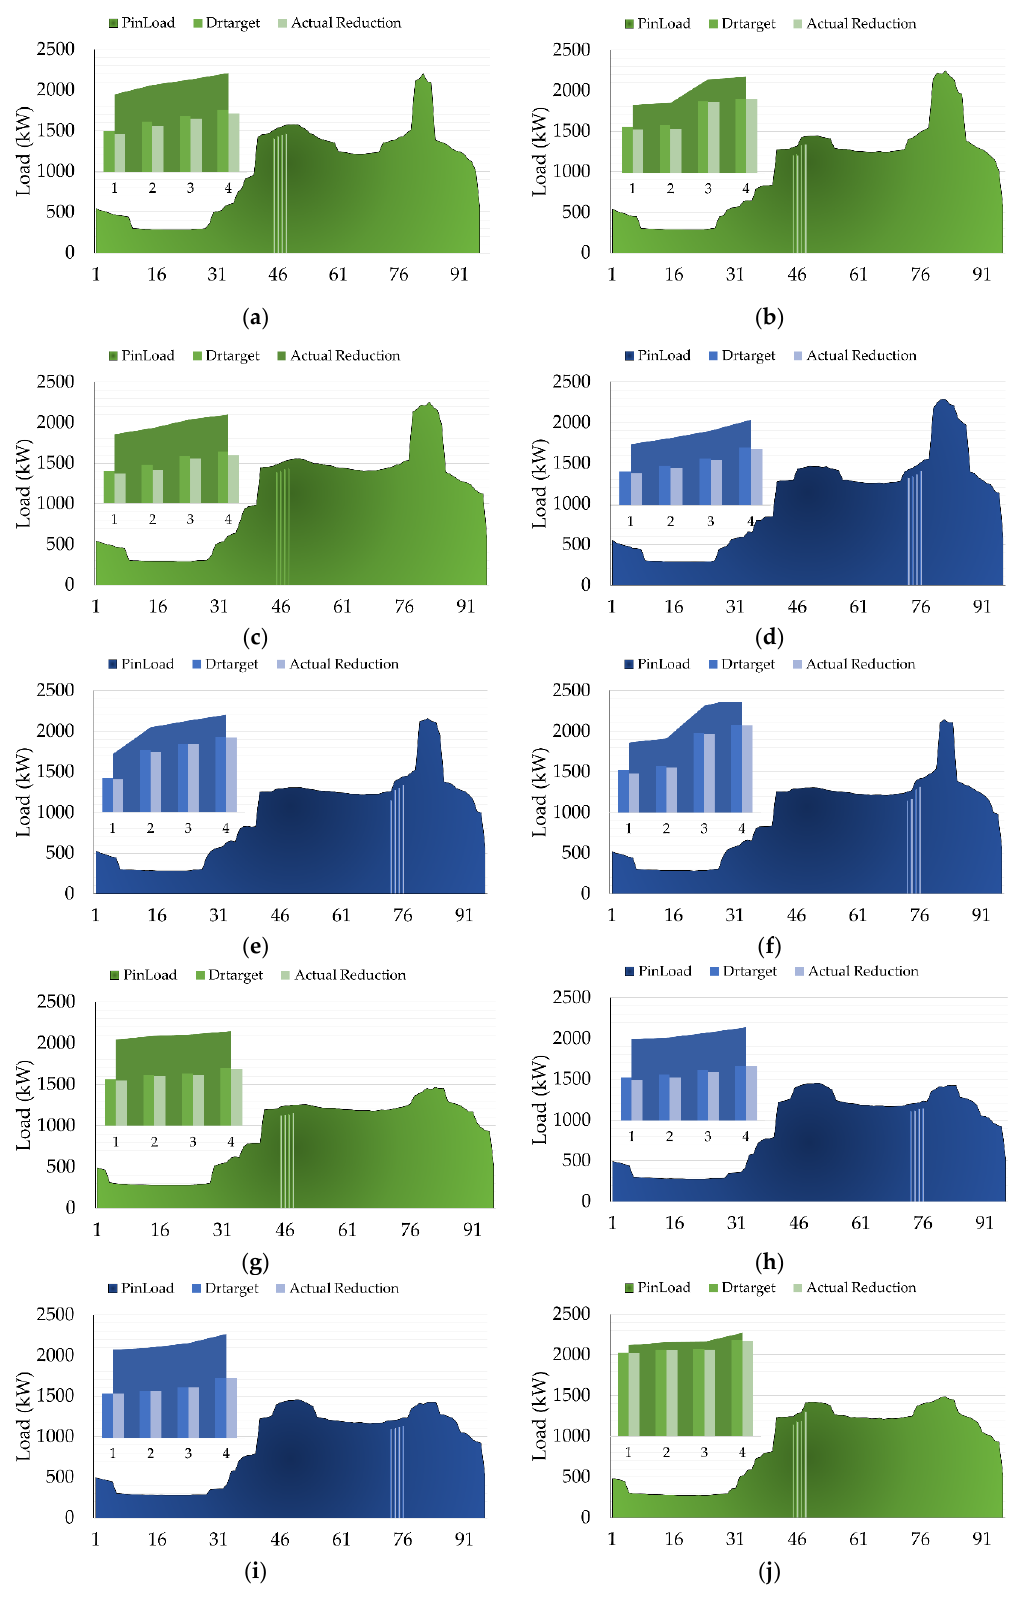
Figure 4. Scheduling results for: ( a ) Day 1, Event 1; ( b ) Day 4, Event 1; ( c ) Day 7, Event 1; ( d ) Day 10, Event 2; ( e ) Day 13, Event 2; ( f ) Day 16, Event 2; ( g ) Day 19, Event 1; ( h ) Day 22, Event 2; ( i ) Day 25, Event 2; ( j ) Day 28, Event